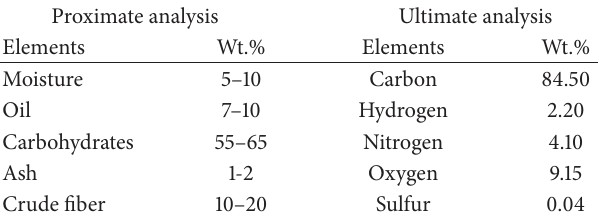
Table 1: Proximate and ultimate analysis of date seed. Proximate